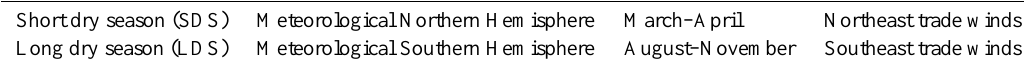
Table 1. Dry seasons in